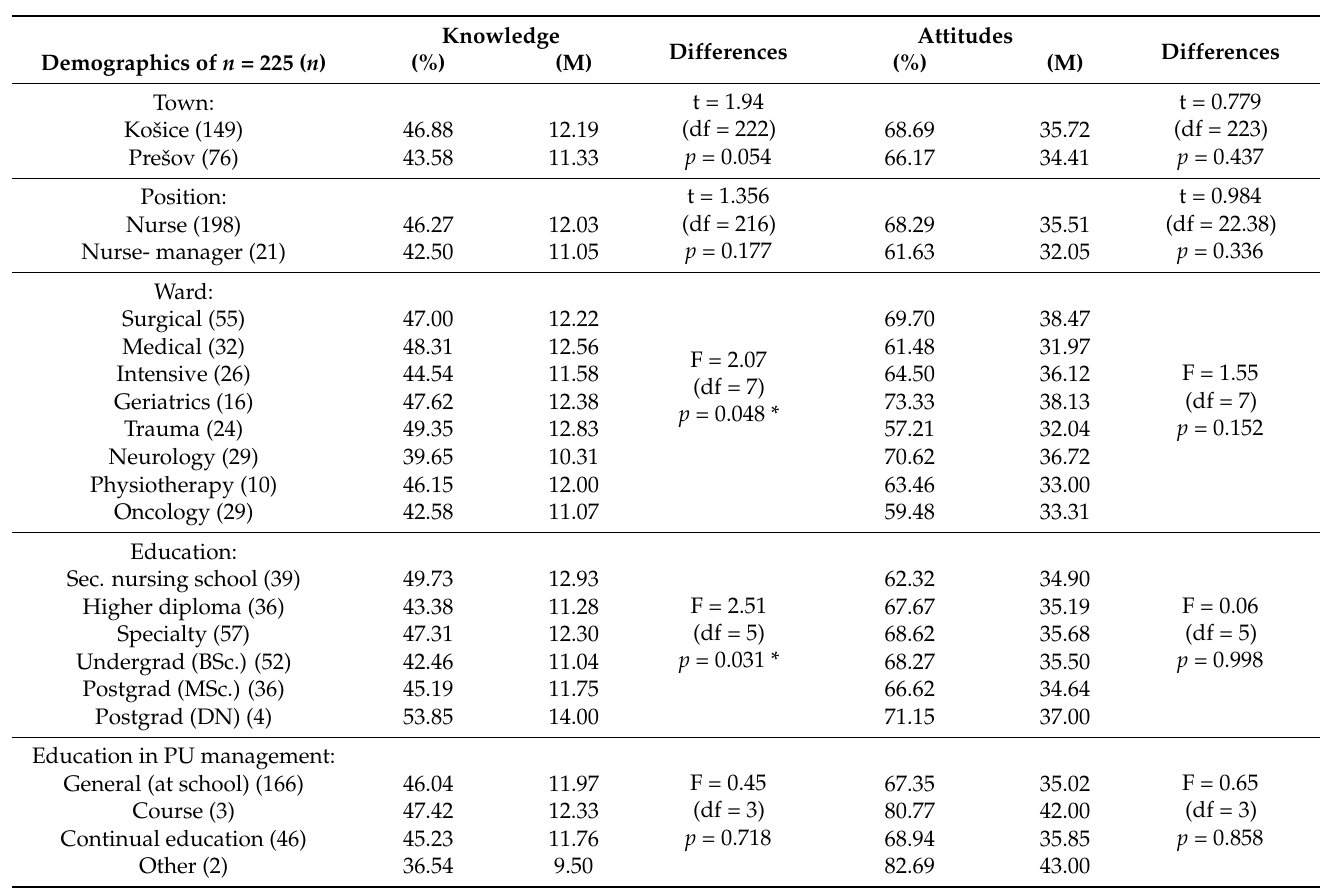
Table 5. Differences between